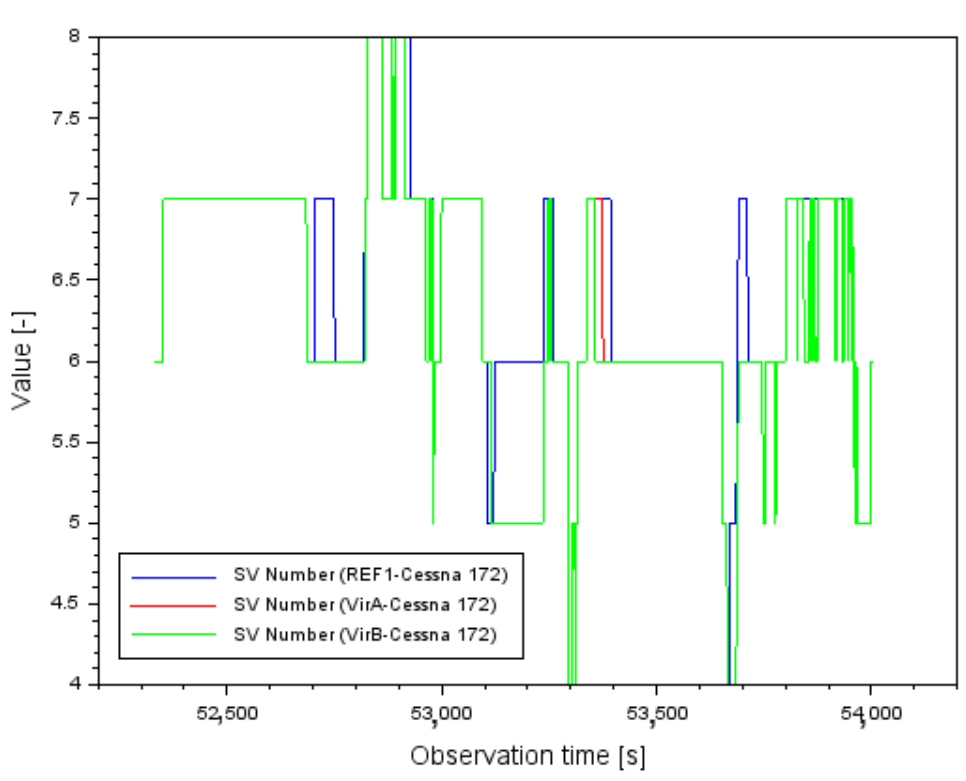
Sensors 2022 , 22 , x FOR PEER REVIEW Figure 3. The values of PDOP for each baseline. Figure 3. The values of PDOP for each baseline.